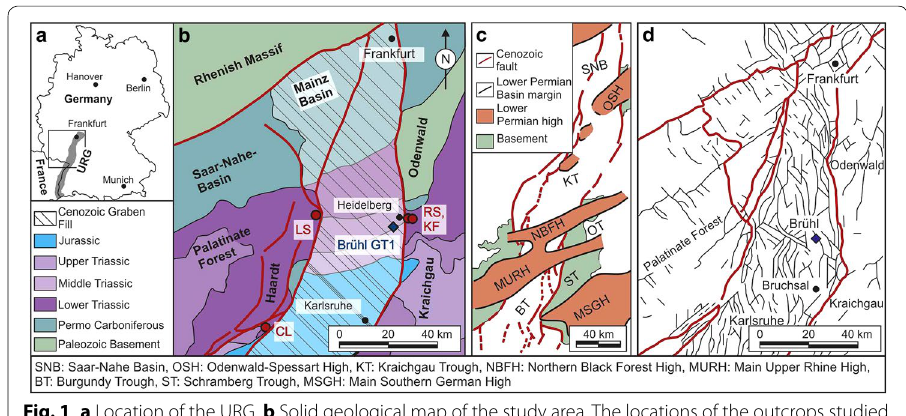
Fig. 1 a Location of the URG. b Solid geological map of the study area. The locations of the outcrops